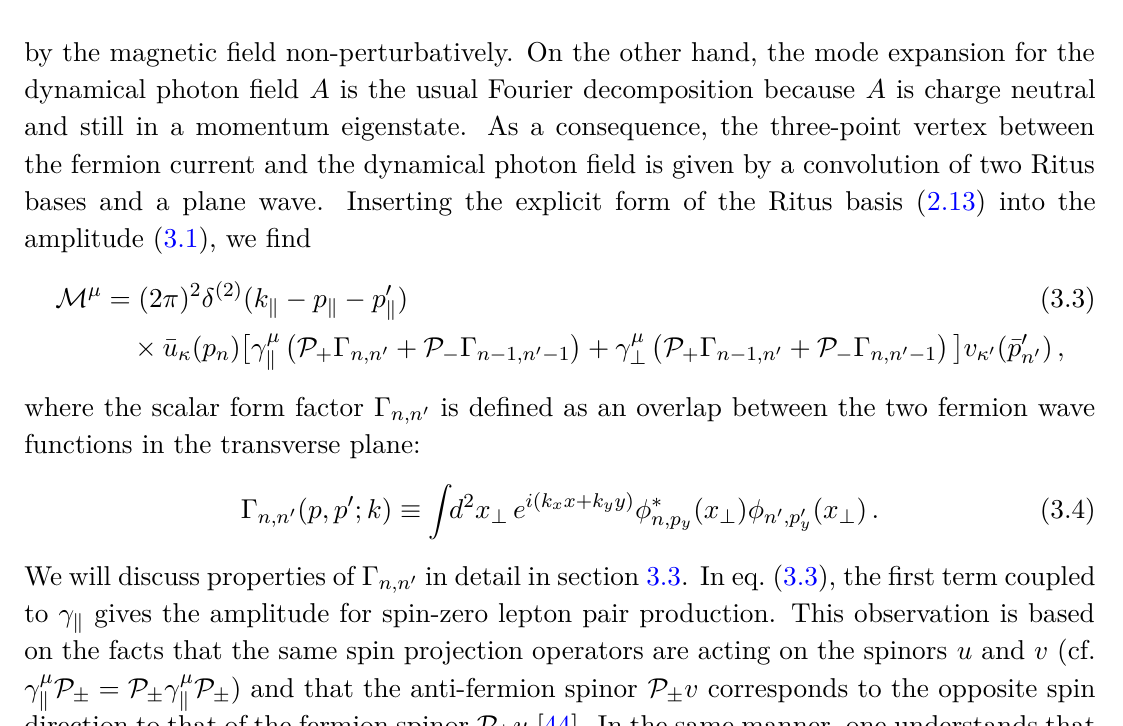
by the magnetic field non-perturbatively. On the other hand, the mode expansion for the dynamical photon field A is the usual Fourier decomposition because A is charge